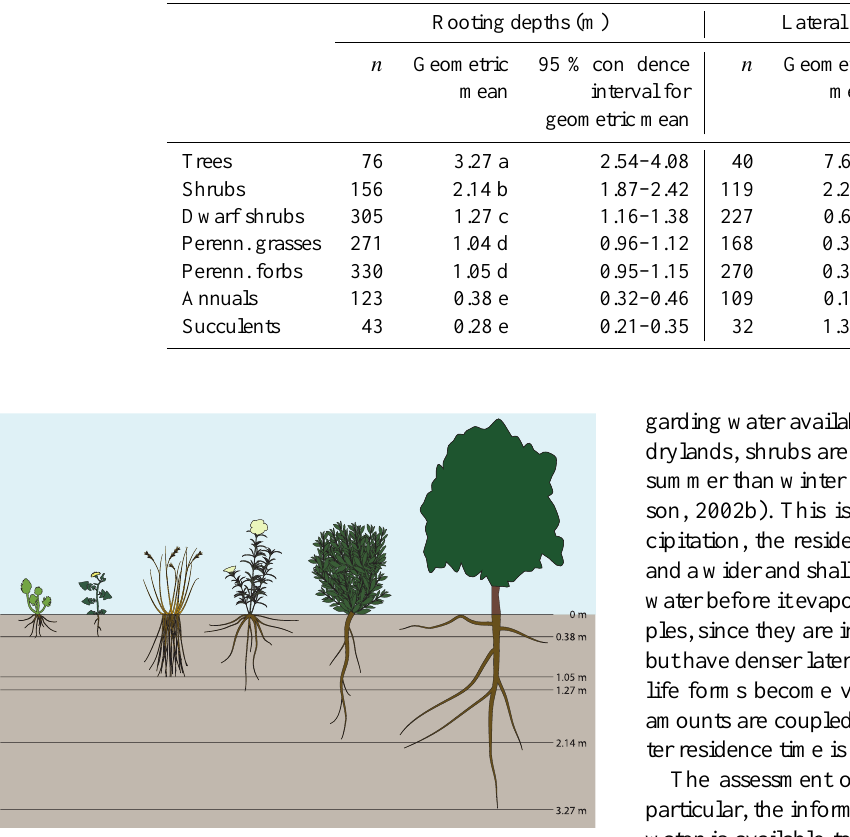
Figure 2. Rooting depths illustrated as schematic drawings of in- dividual plants using approximate geometric mean values for six growth form categories (from left to right): succulents, annual herbs, perennial herbs, dwarf shrubs, shrubs, and trees. Root depths’ means were retrieved from Schenk and Jackson